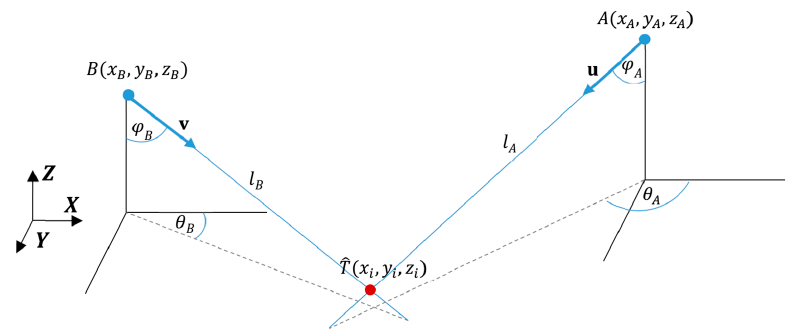
Figure 2. Graphical interpretation of the 3D AoA ranging technique.